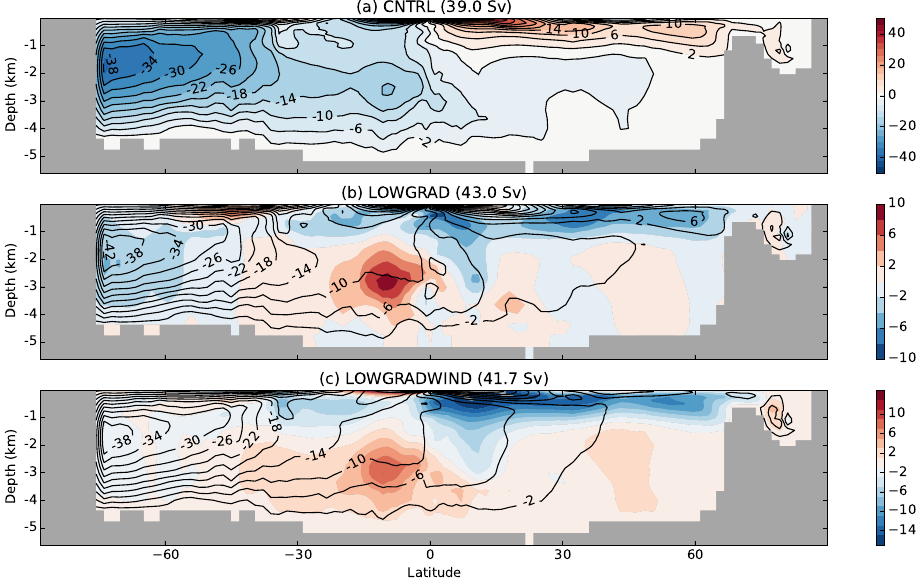
Figure 3. Global meridional overturning circulation streamfunction for (a) the control case CNTRL, with colour plot representing the streamfunction (b) the low temperature gradient case, LOWGRAD, with colour plot representing LOWGRAD–CNTRL streamfunction difference and (c) the low temperature and weak wind case, LOWGRADWIND, with colour plot representing LOWGRADWIND–CNTRL streamfunction difference. Values are given in Sv (1Sv = 10 6 m 3 s − 1 ). The strength of the Southern Hemisphere overturning cell is given in parentheses in the captions.